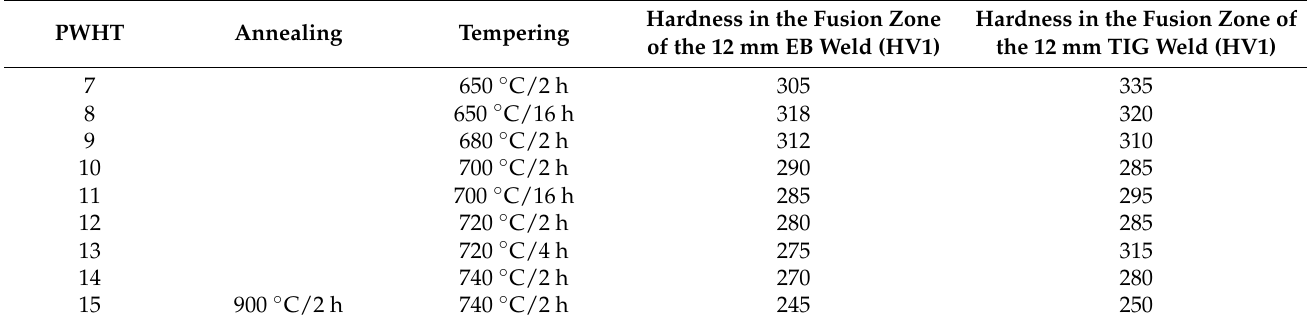
Table 3. PWHTs applied to 12 mm EB and TIG welds. Hardness is given in pairs where the left number refers to EB and the right to the TIG weld